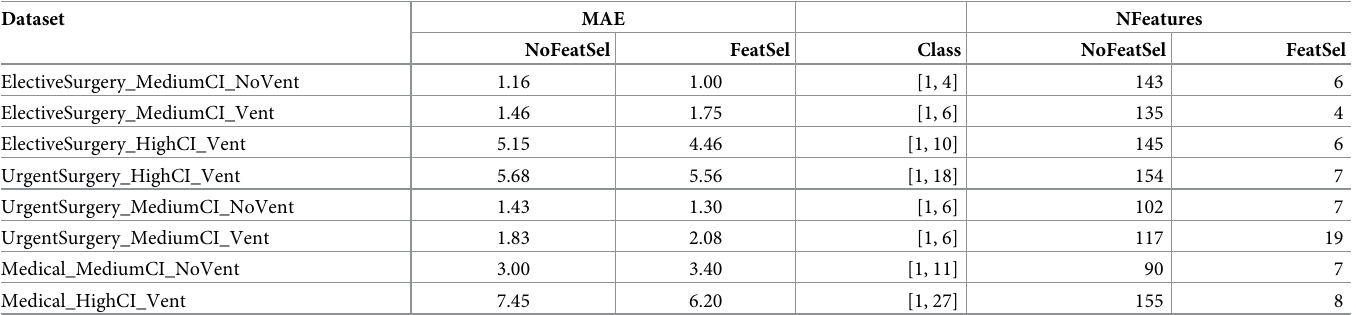
Table 5. An overview of LoS prediction. Each class with at least 50 patients is considered separately as a dataset, CI in the name of the dataset stands for Care Intensity. Accuracy is computed as average MAE—expressed in number of days. Feature selection can be enabled (FeatSel) or not (NoFeatSel), column Class reports the LoS range provided by classification, outliers